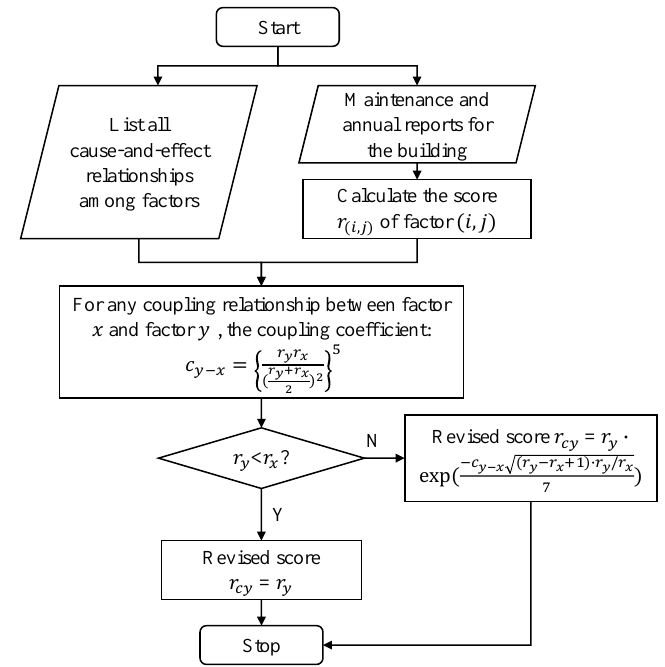
Figure 6. The flow chart of our coupling revision